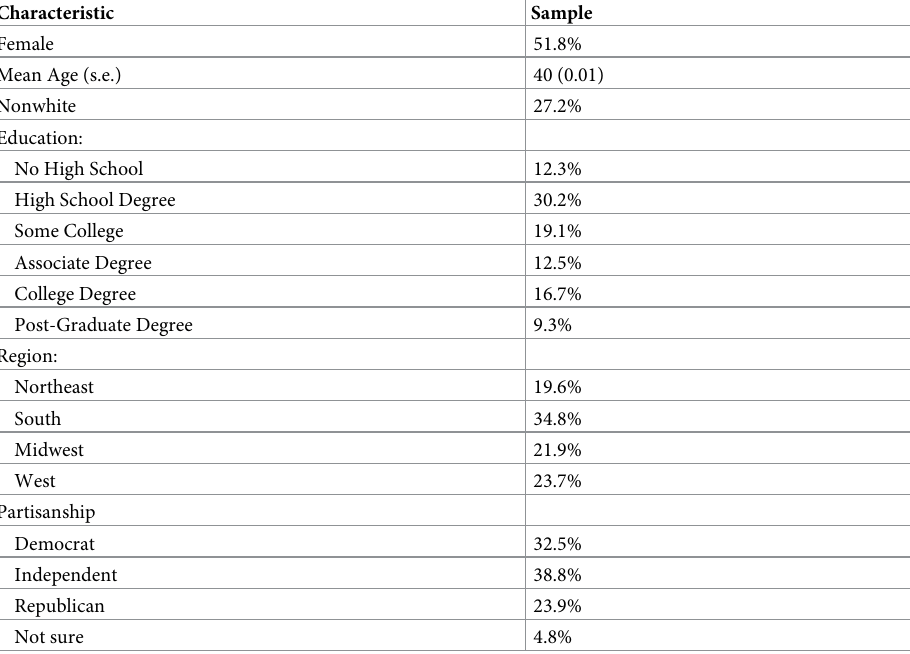
Table 1. Sample demographics, weighted